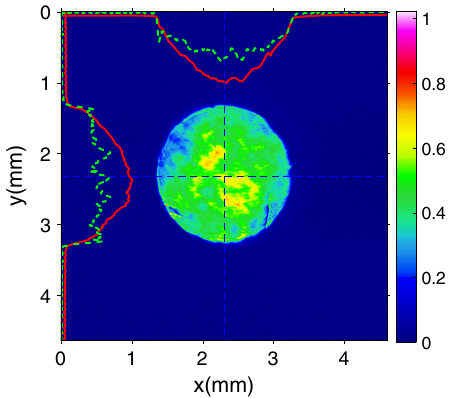
FIG. 3. Transverse profile of UV laser when the BSA is 2 mm. The red solid lines are horizontal and vertical projections. The green dotted lines are the distributions at the blue dashed line positions.